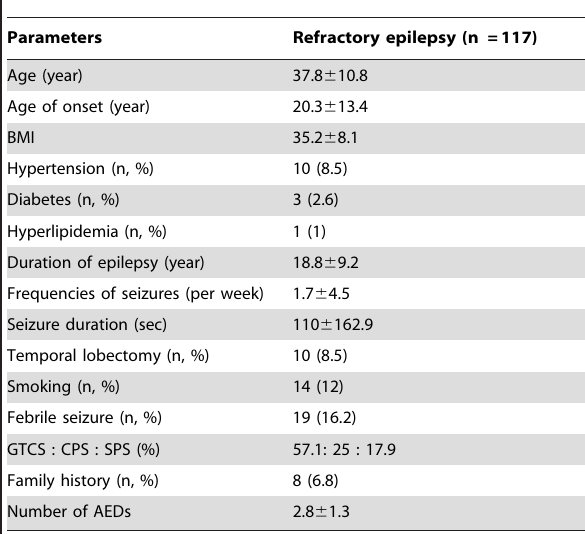
Table 1. Refractory epilepsy patient demographics.